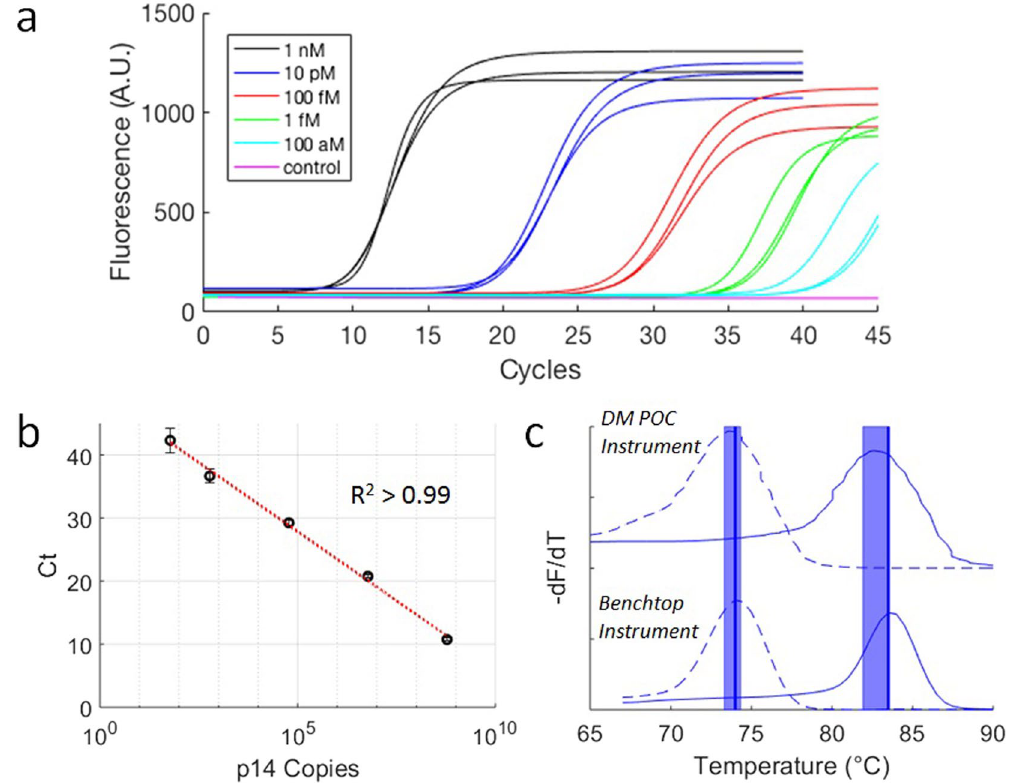
Figure 5. Cartridge PCR and melt performance. ( a ) Real-time fluorescence of PCR thermal cycling on cartridge using 10 µ l PCR solutions directly spiked with dilutions of synthetic p14(ARF) oligonucleotide targets ranging from 1 nM to 100 aM in concentration (n = 3 for each dilution). No specific amplification was detected with a negative control (pink). ( b ) Standard curve generated from the cycle threshold (Ct) values calculated from the PCR in ( a ). ( c ) Comparison of p14(ARF) amplicon melt curves generated by our instrument (top) with those generated by a commercial benchtop thermocycler (bottom). The dashed lines indicate the low melt temperature curve of a shorter nonspecific product that is amplified when a PCR solution is left at room temperature for several hours, while the solid lines are melt curves of the desired amplicon products produced when the target is present in the PCR solution. The dark vertical lines represent the benchtop thermal cycler melt temperatures (Tm = 74 °C and 83.5 °C) which had a 0.5 °C resolution and were consistent between runs. The broader vertical bars denote one standard deviation from the average melt temperatures detected with the cartridges (Tm = 73.8 ± 0.5 °C and 82.7 ± 0.8